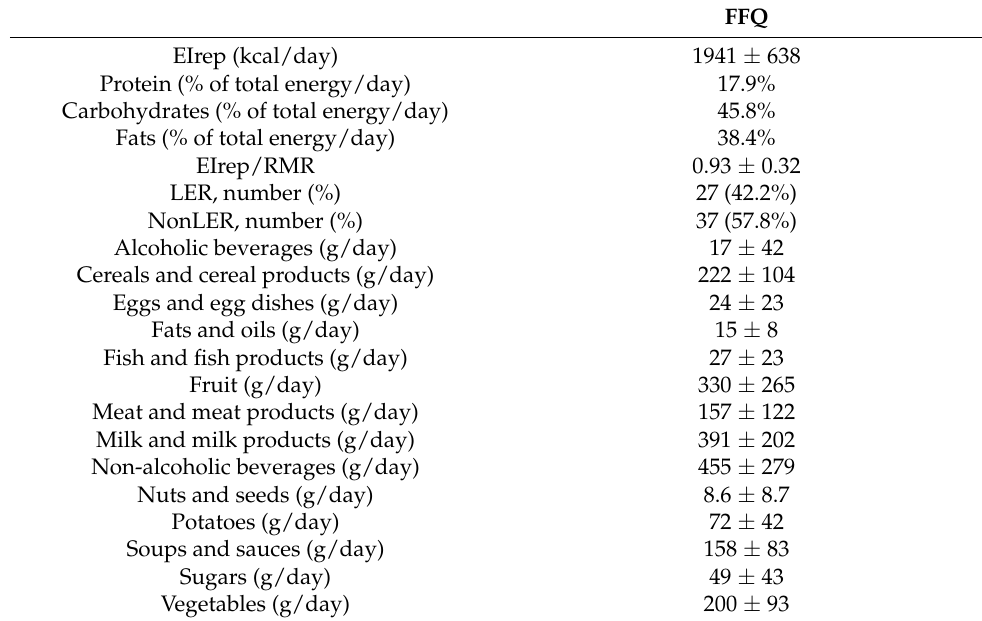
Table 5. Daily energy and food group intakes in pregnant women assessed by EPIC-Norfolk food frequency questionnaire